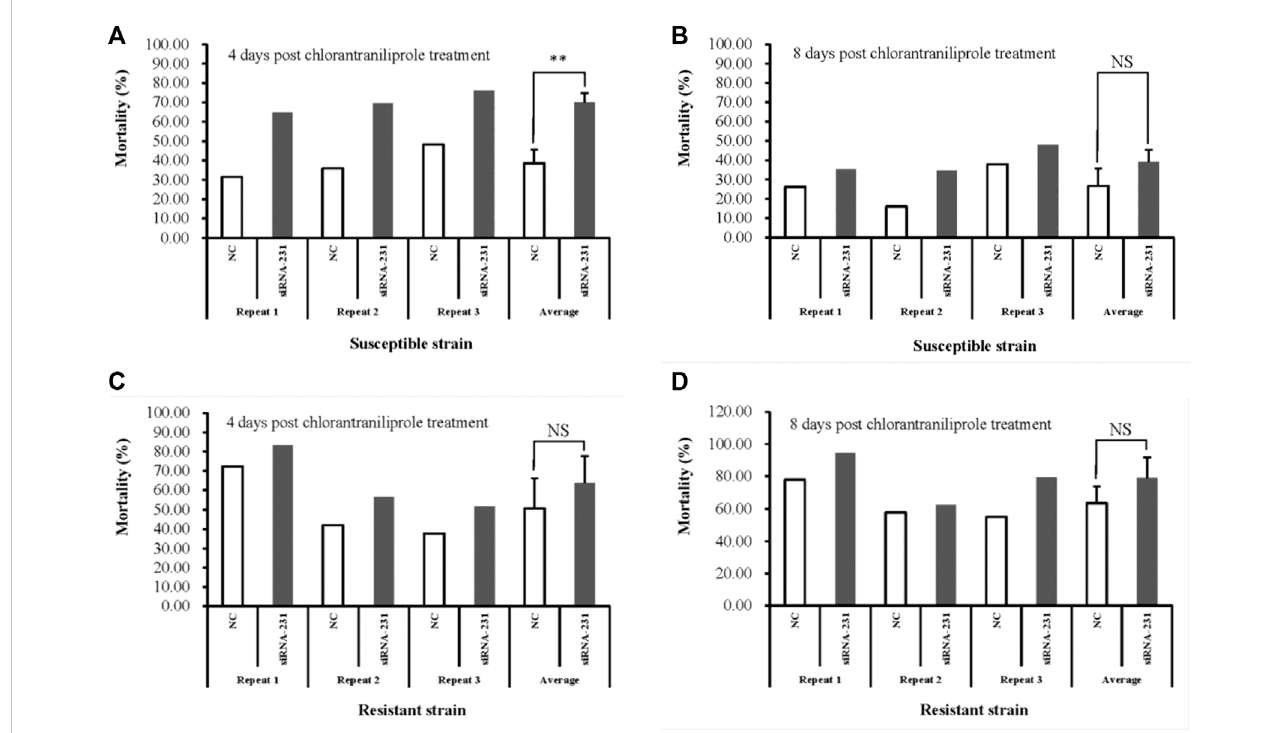
FIGURE 9 Susceptibility to chlorantraniliprole after silencing MSTRG.7482.1 with siRNA. The toxicity assay was conducted in both the S strain (A,B) and R strain (C,D) . Mortality was calculated 96 h after chlorantraniliprole exposure. All experiments were conducted in triplicate. Asterisks on the error bars show signi fi cant differences ( p < 01). NS on the error bars, however, show no signi fi cant